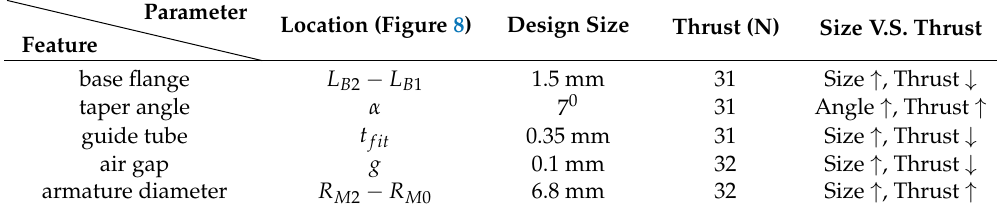
Table 4. The relevant parameters are summarized and compared.